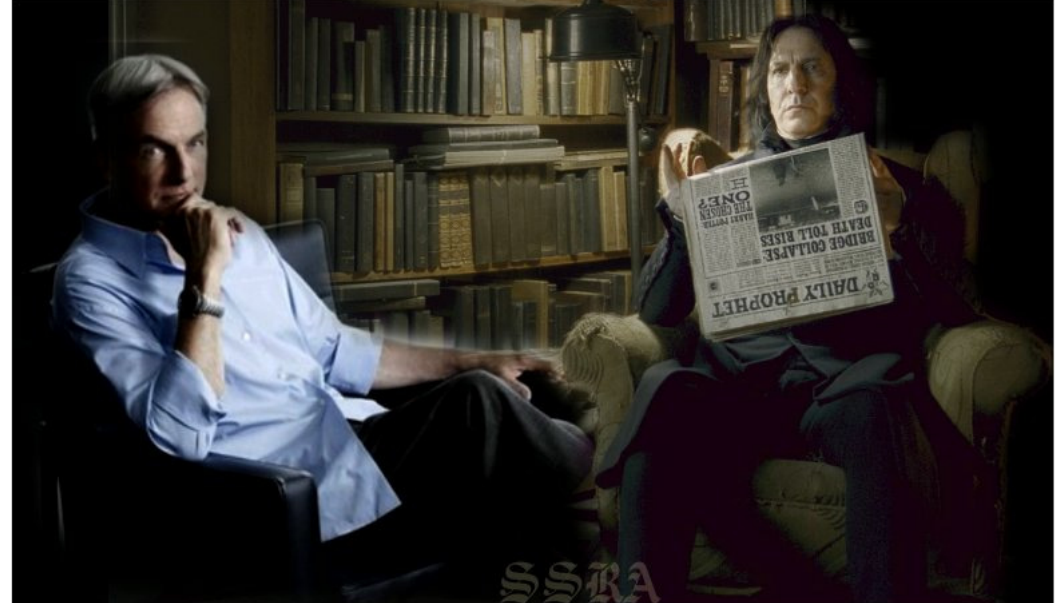
Figure 6. A photomanipulation of Snape and Agent Gibbs from television series ‘NCIS’, made by Rose